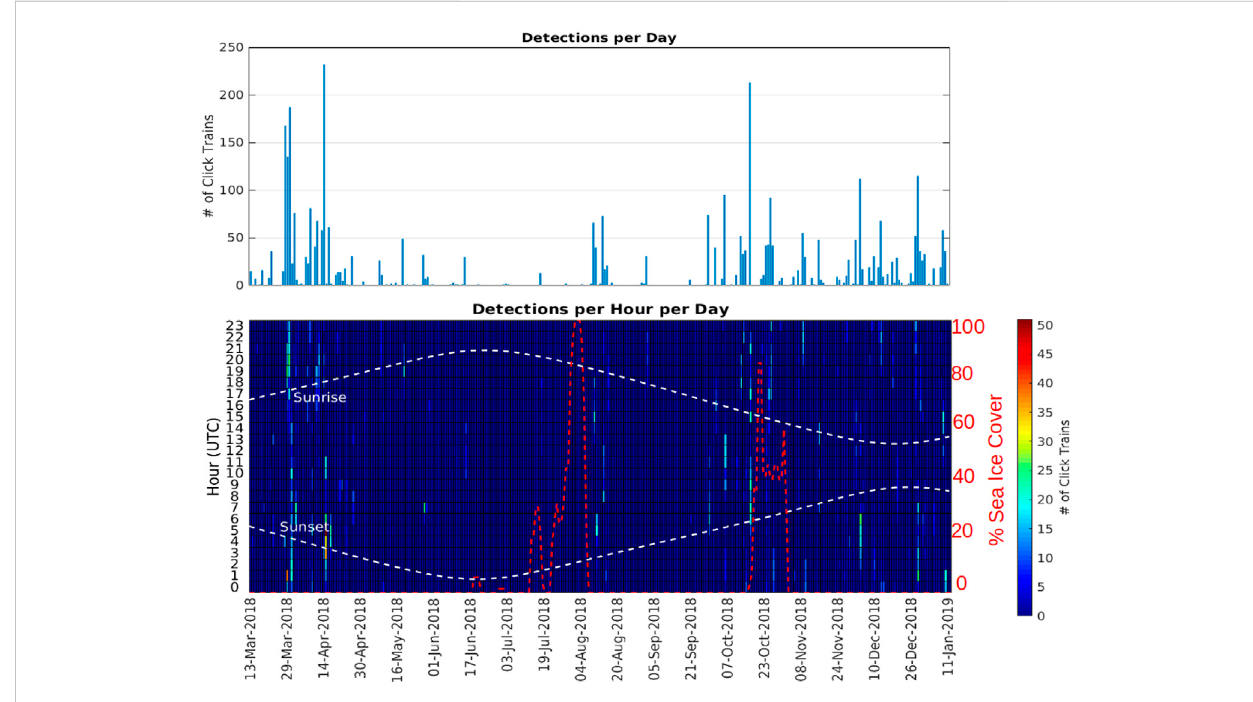
FIGURE 6 Number of echolocation click trains detected at station A3 as a function of day (top panel) and as a function of day and hour of the day (bottom panel). The red dashed line indicates the sea ice percentage cover measured at the location of A3 ( < 15 km range).